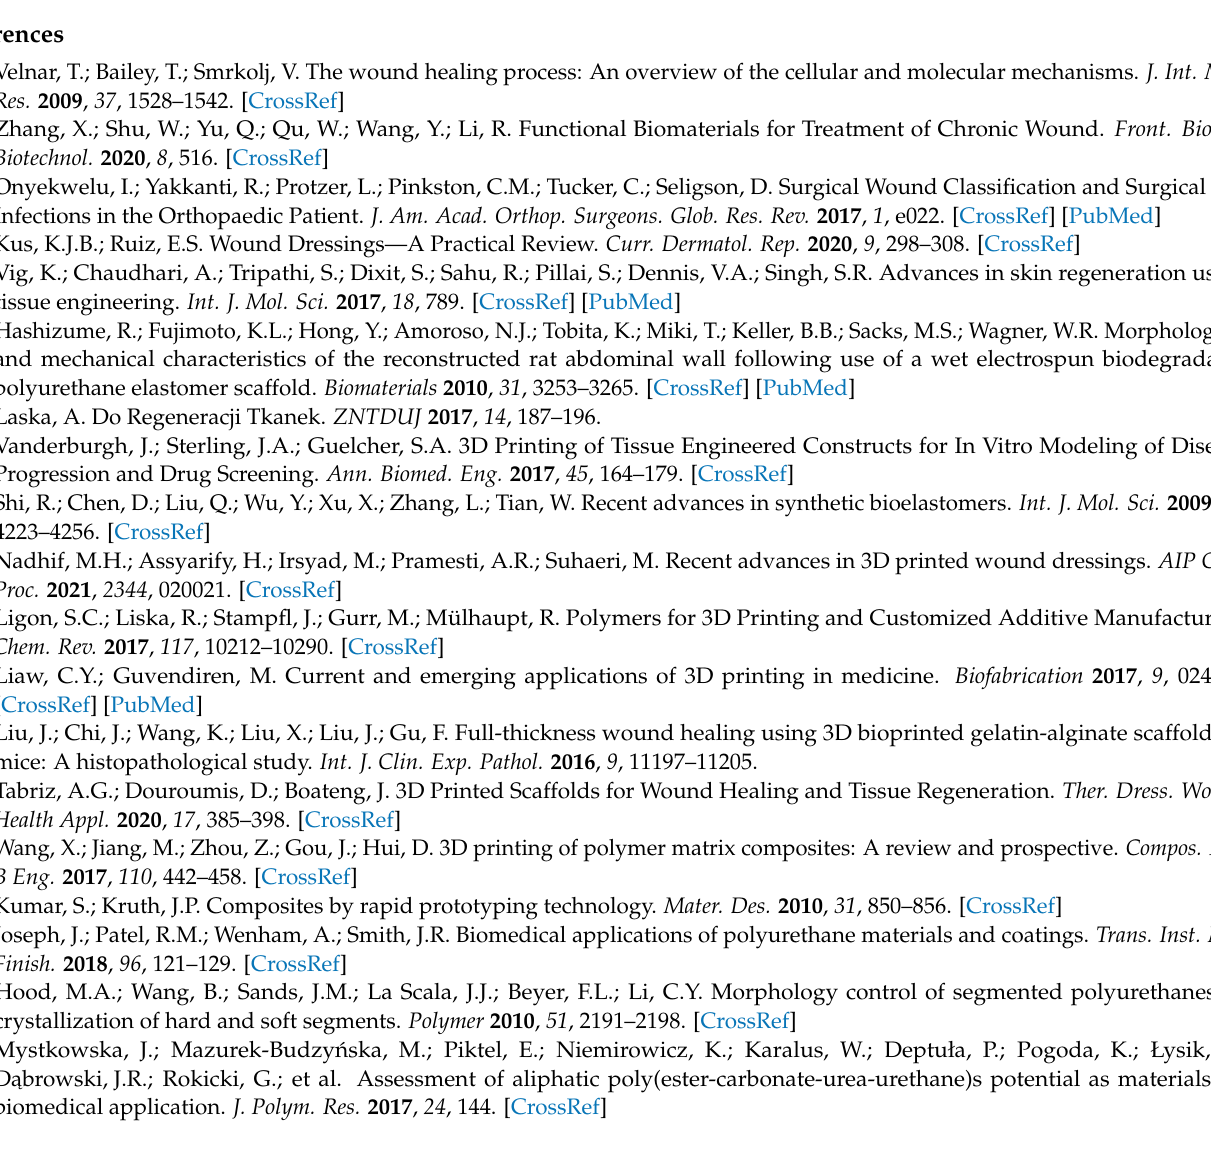
before and after degradation in 0.1M CoCl 2 in 20% H 2 O 2